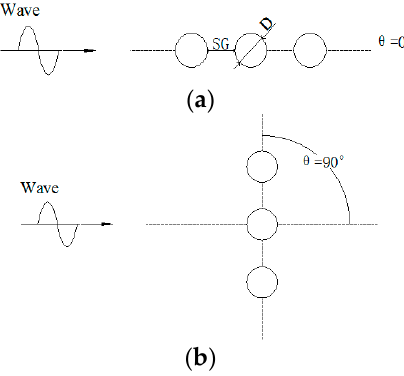
Figure 3. Sketch of the pile group arrangements: ( a ) side-by-side; ( b ) tandem.